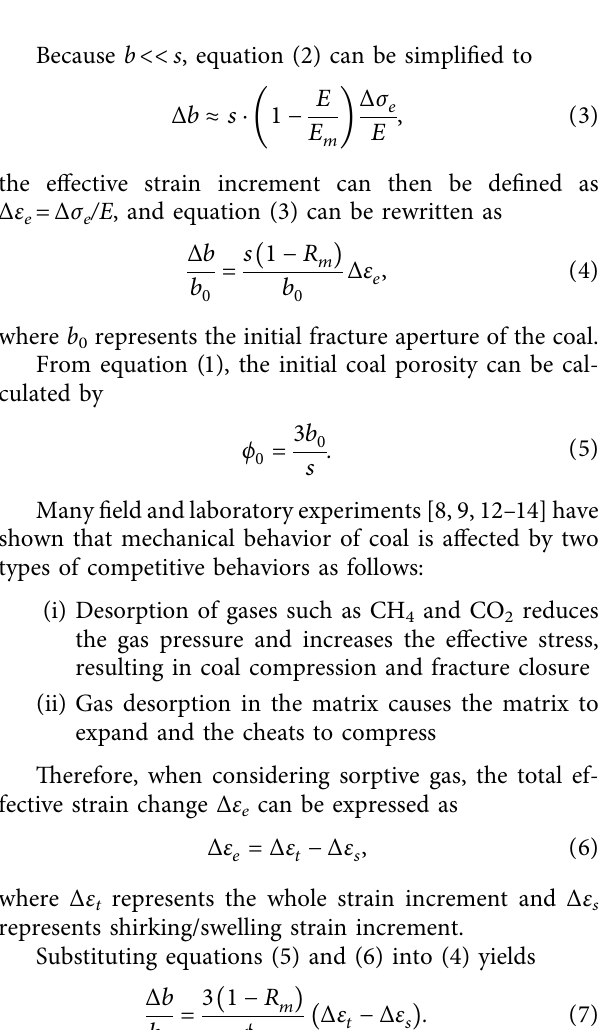
Figure 1: Schematic of the coal model consisting of matrix and